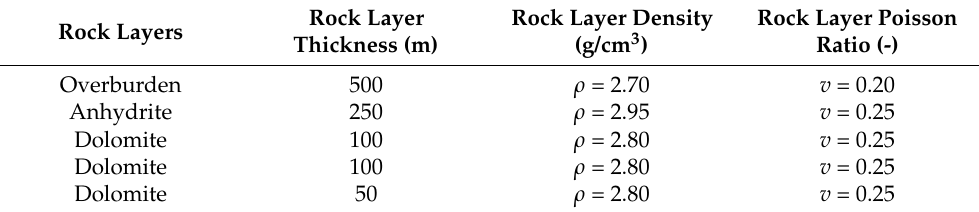
Table 3. Rock mass parameters for the excavation drilled in